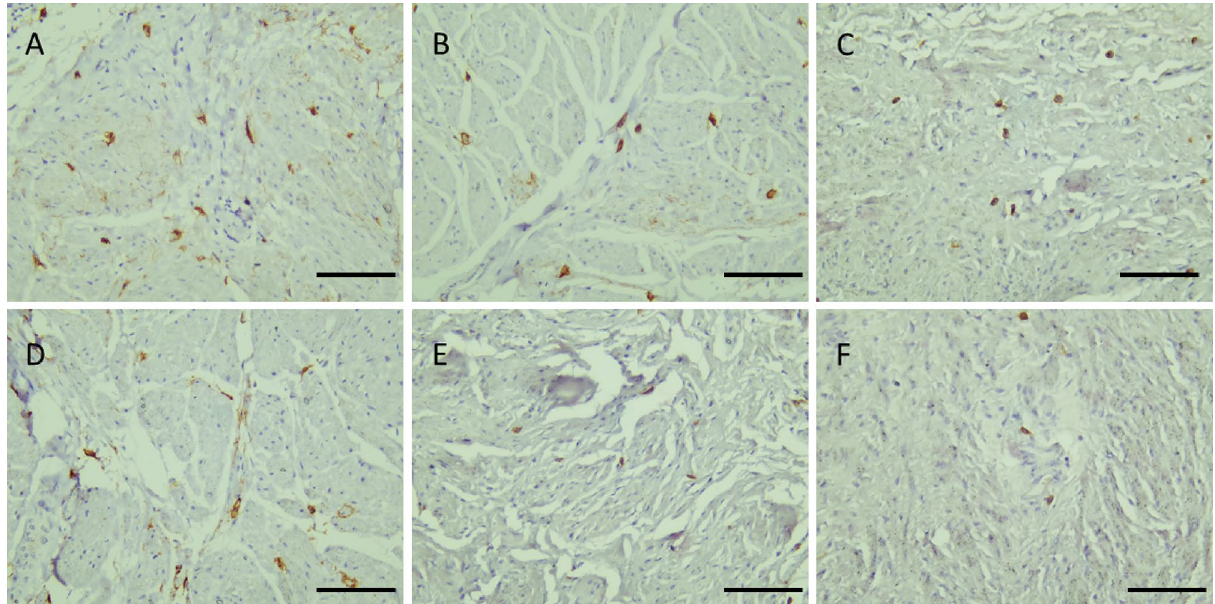
Figure 2. cKit IHC shows distribution of c-Kit positive cells in different samples of normal-appearing tissue of urinary bladder with UBC. ( A , B , C ): MIBC. ( D , E ): NMIBC, high grade and ( F ): NMIBC low grade. (× 200, scale bar 50